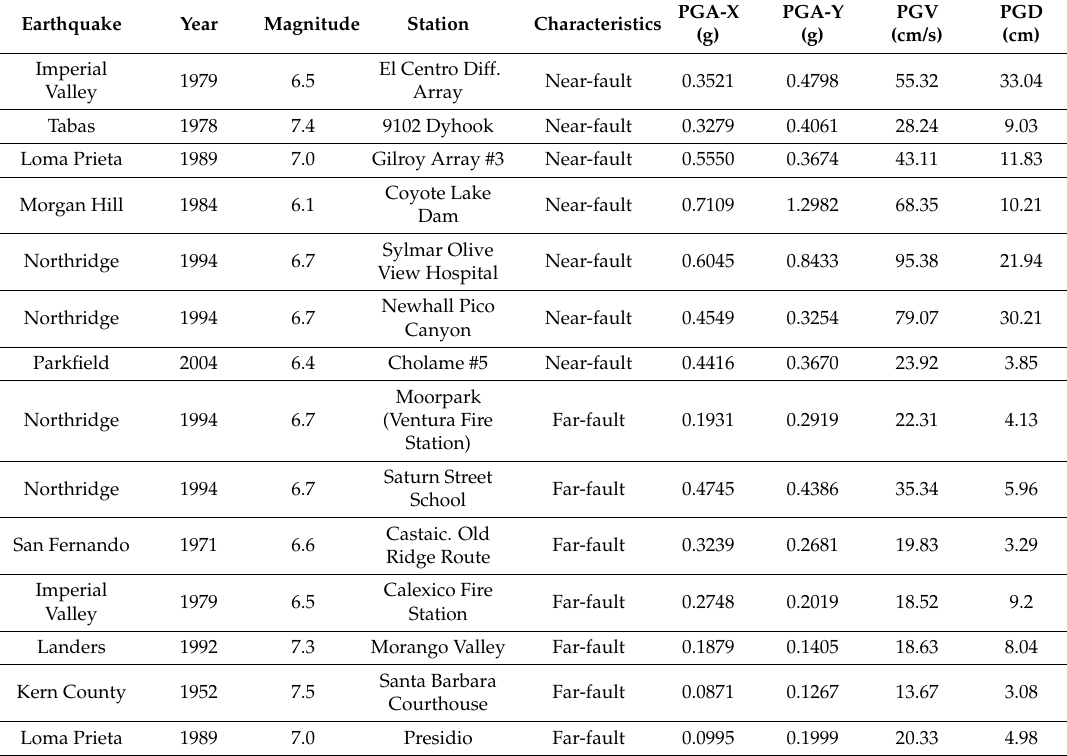
Table 3. Earthquake records considered in the study